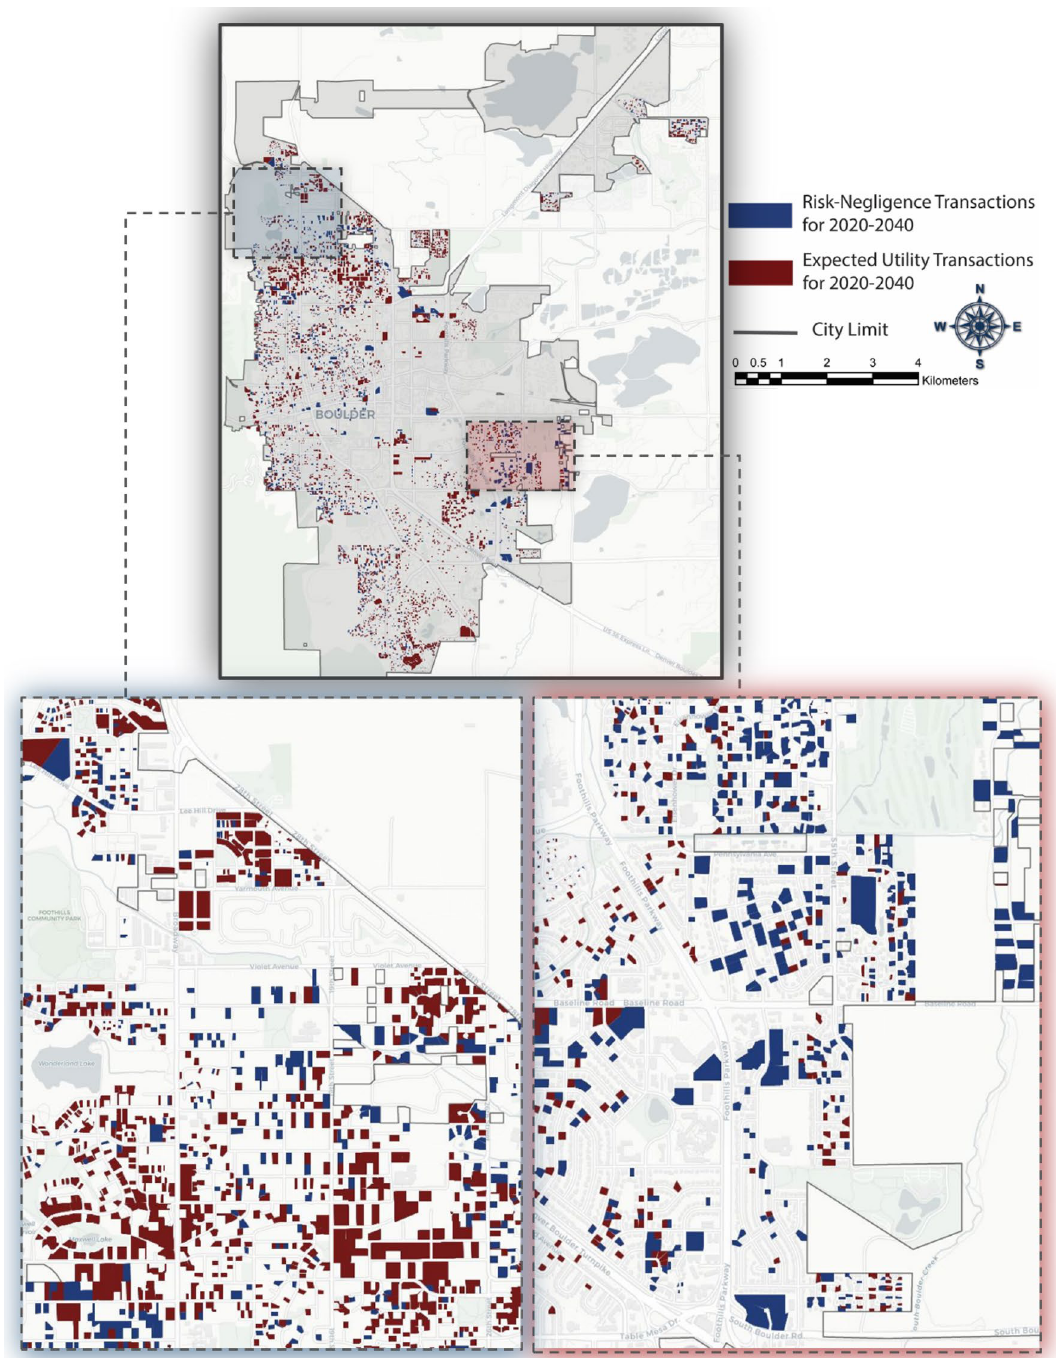
Figure 4. Future projections of buyers’ choices from 2020 to 2040—figures created using Python 3.9.5 (https:// www. python. org/